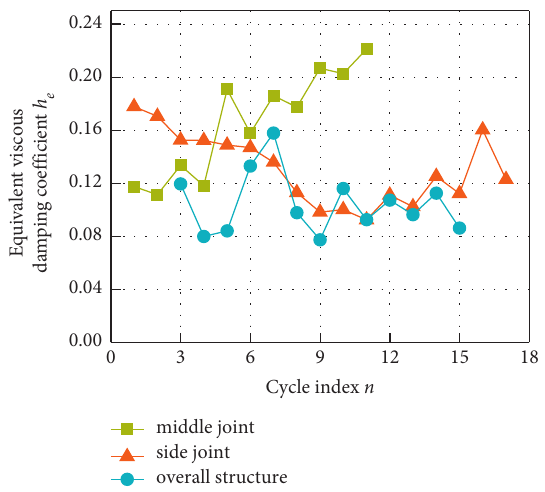
Figure 8: Equivalent viscous damping